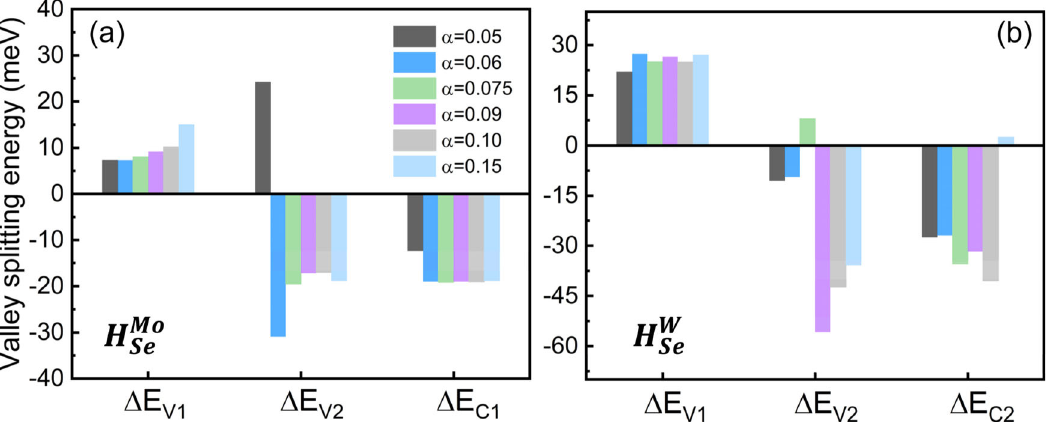
Fig. 4 Valley splittings of H M stacked MSe 2 /VSe 2 under varied exchange strength. The valley splittings Δ E V1 , Δ E V2 , and Δ E C1(C2) for the Se topmost valence band, the second topmost valence band, and lowest conduction band (second lowest conduction band) of H M MoSe 2 /VSe 2 ( a ) and WSe 2 /VSe 2 ( b ) using HSE with different α coef fi cients and fi xed μ = 0.2 Å − 1